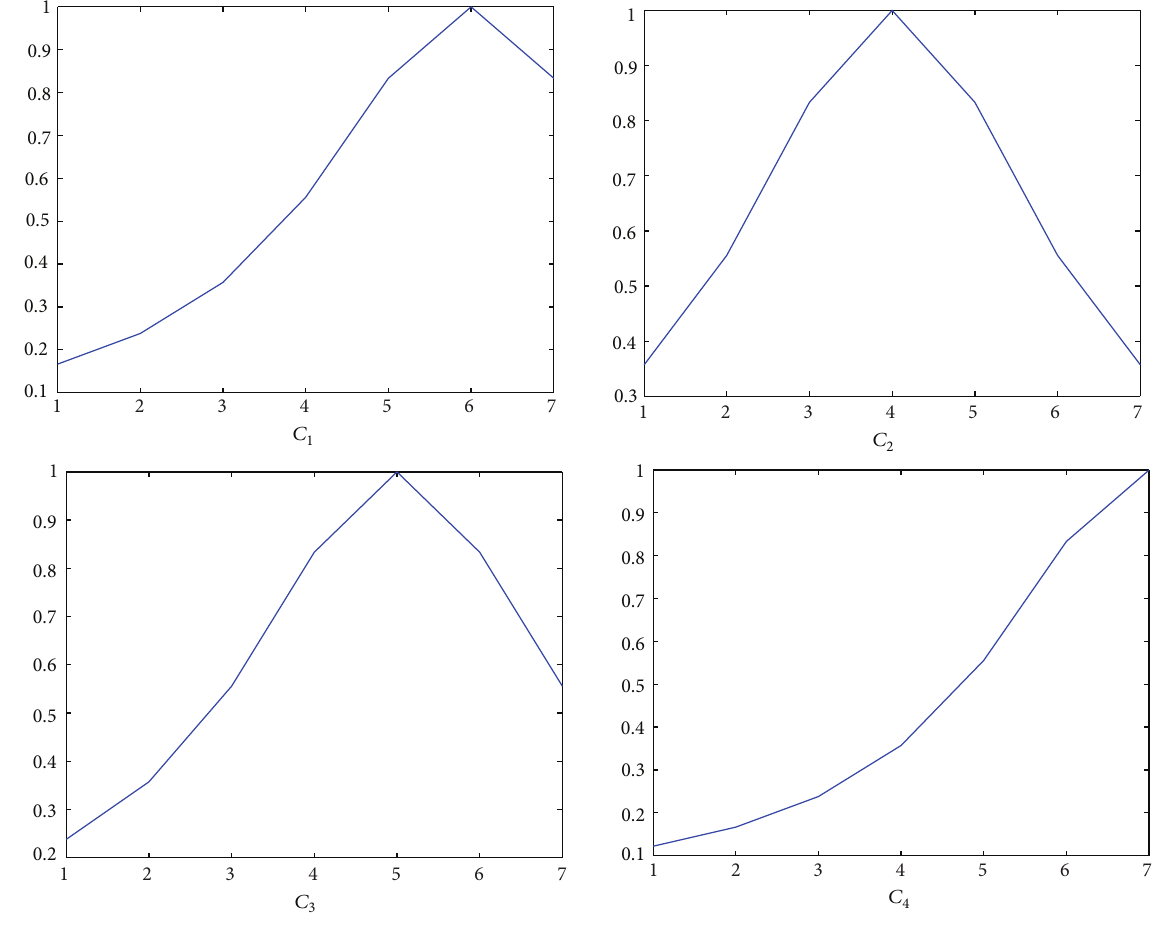
Figure 4: Membership function for the weighting of criteria 𝐶 1 – 𝐶 4